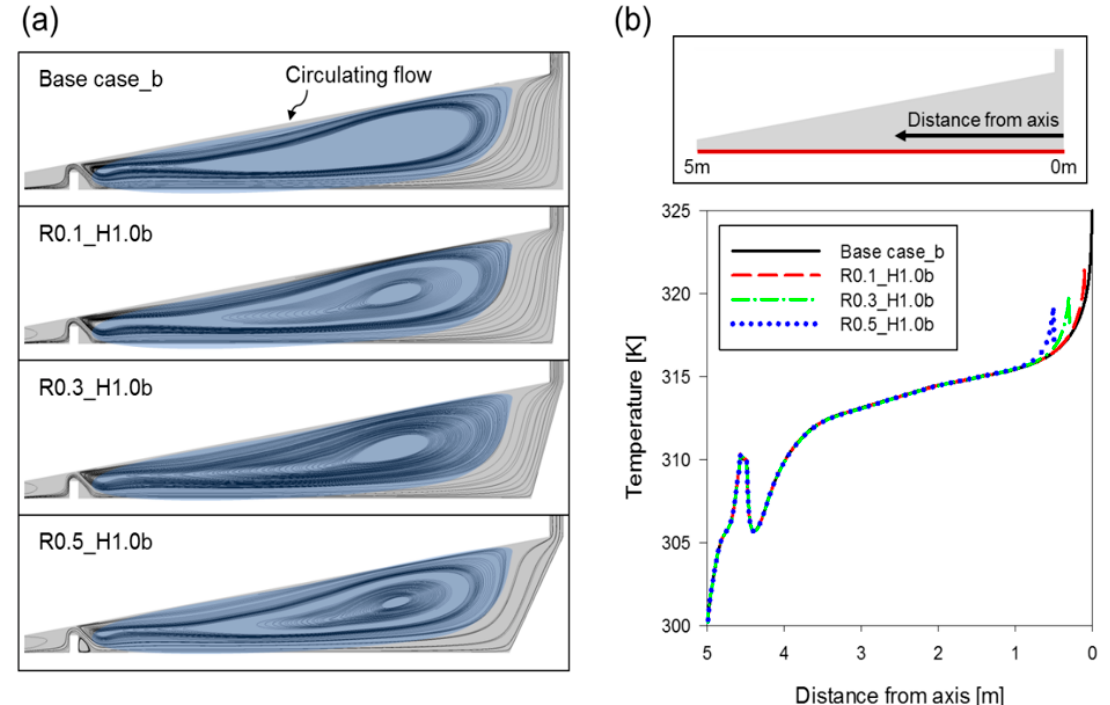
Figure 8. Additive effects of the baffle and CGP. ( a ) Streamlines obtained via computational fluid dynamics (CFD) modeling of the internal flow field of the SUT models with different CGP radii and a constant height of 1.0 m. ( b ) Temperature profiles at the absorber at the ground, as indicated by the red line in the inset above.